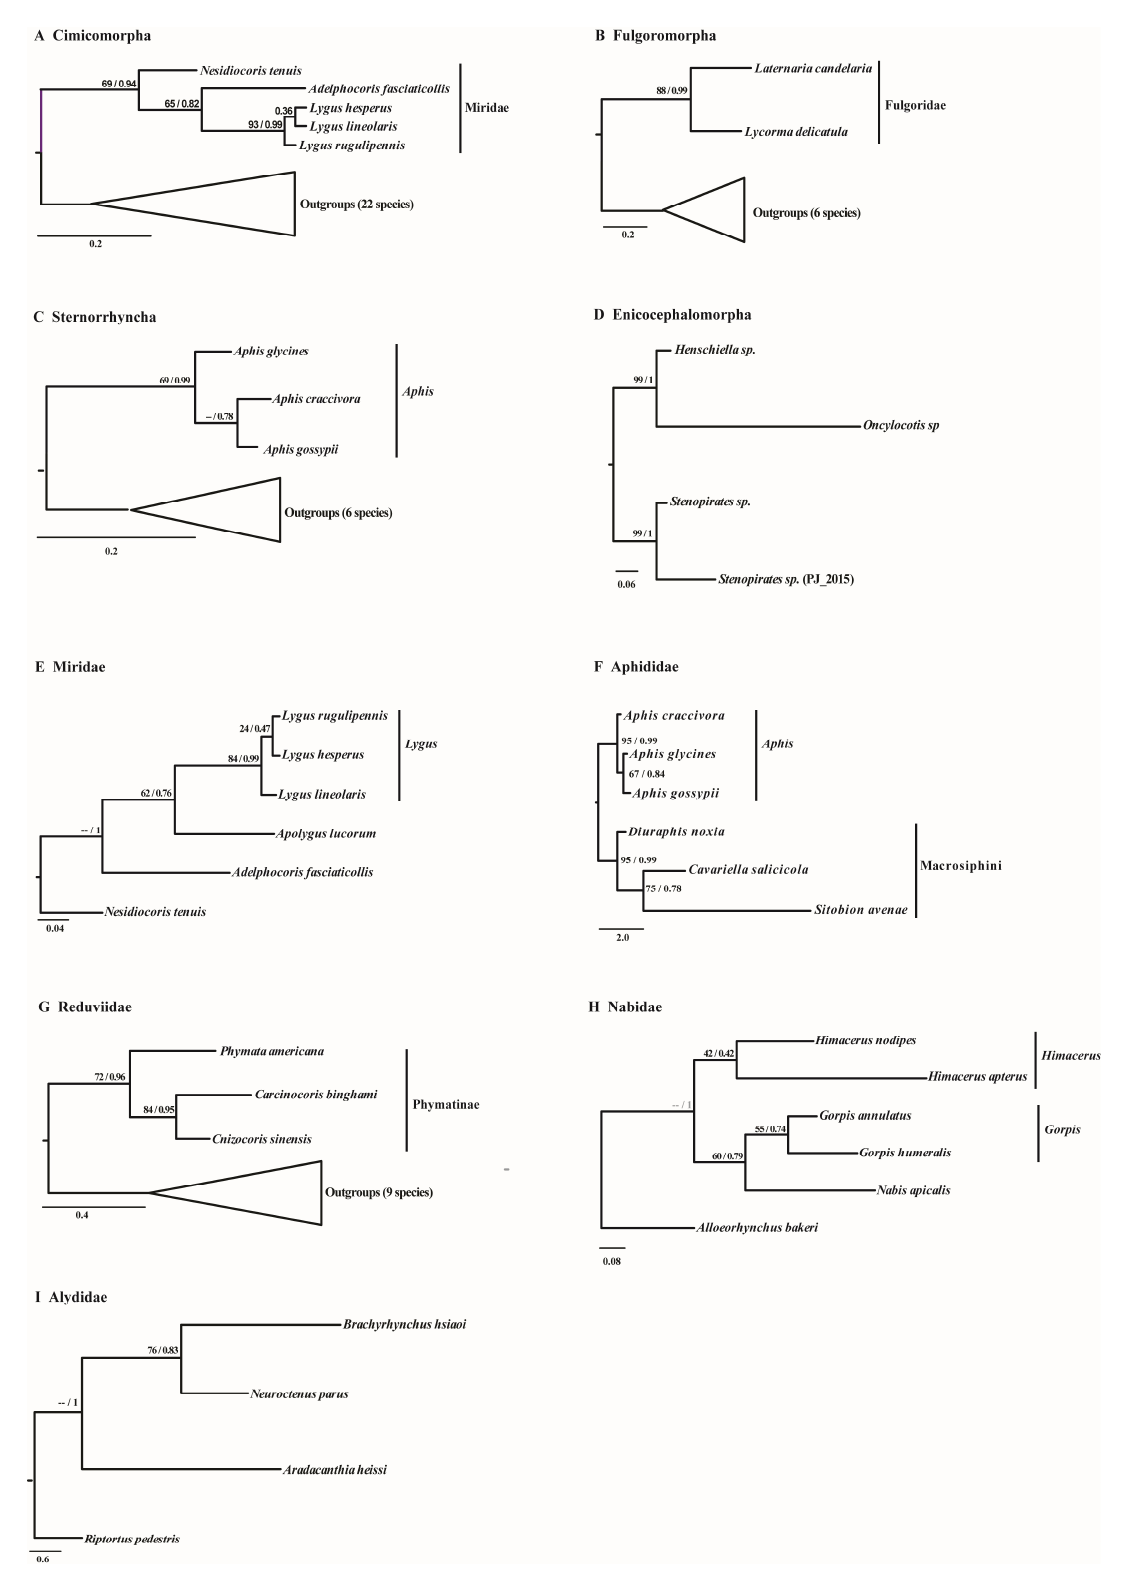
Figure 2. Phylogenetic trees ( A – I ) of different groups in Hemiptera, based on 19 conserved sequence block (CSB) datasets recovered by Bayesian and maximum likelihood analyses. Maximum likelihood bootstrap values and Bayesian posterior probability are indicated at each node.